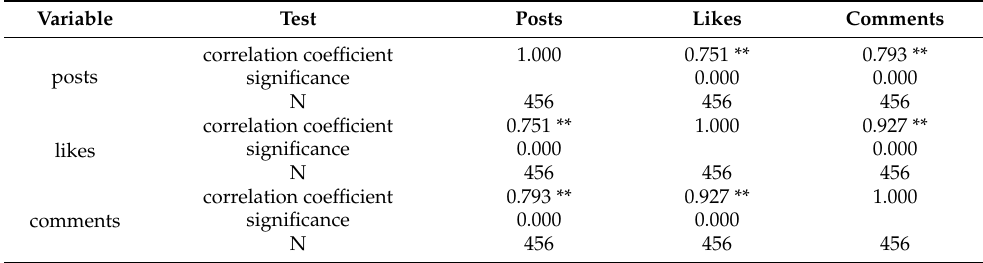
Table 3. Spearman’s rank correlation coefficient (posts, likes and